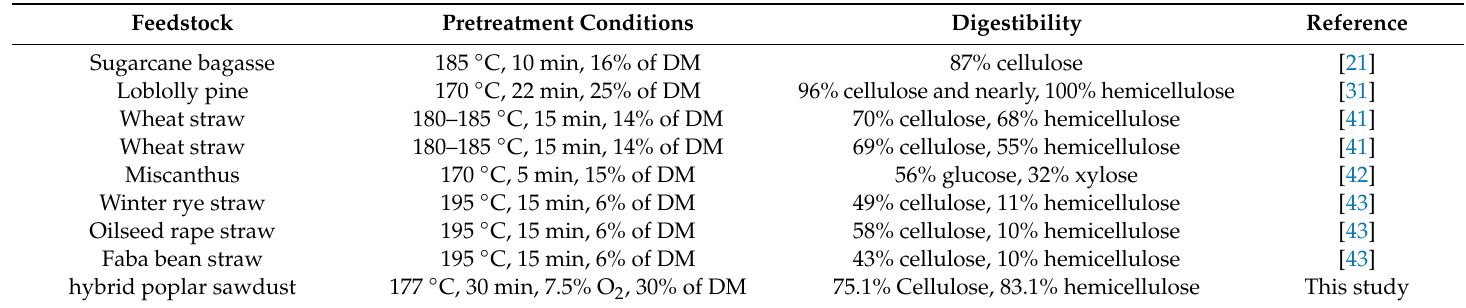
Table 3. Comparison of biomass digestibility with other feedstock pretreated by wet explosion